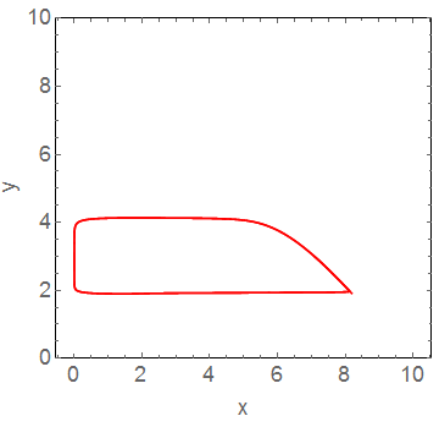
Figure 3. The phase portrait of System (7), where the orbit is shown in red in the phase space.